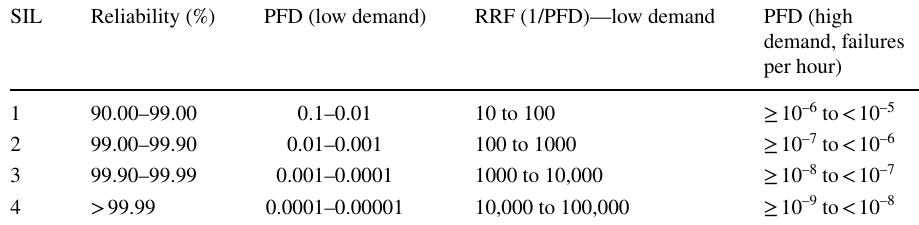
SIL Reliability (%) PFD (low